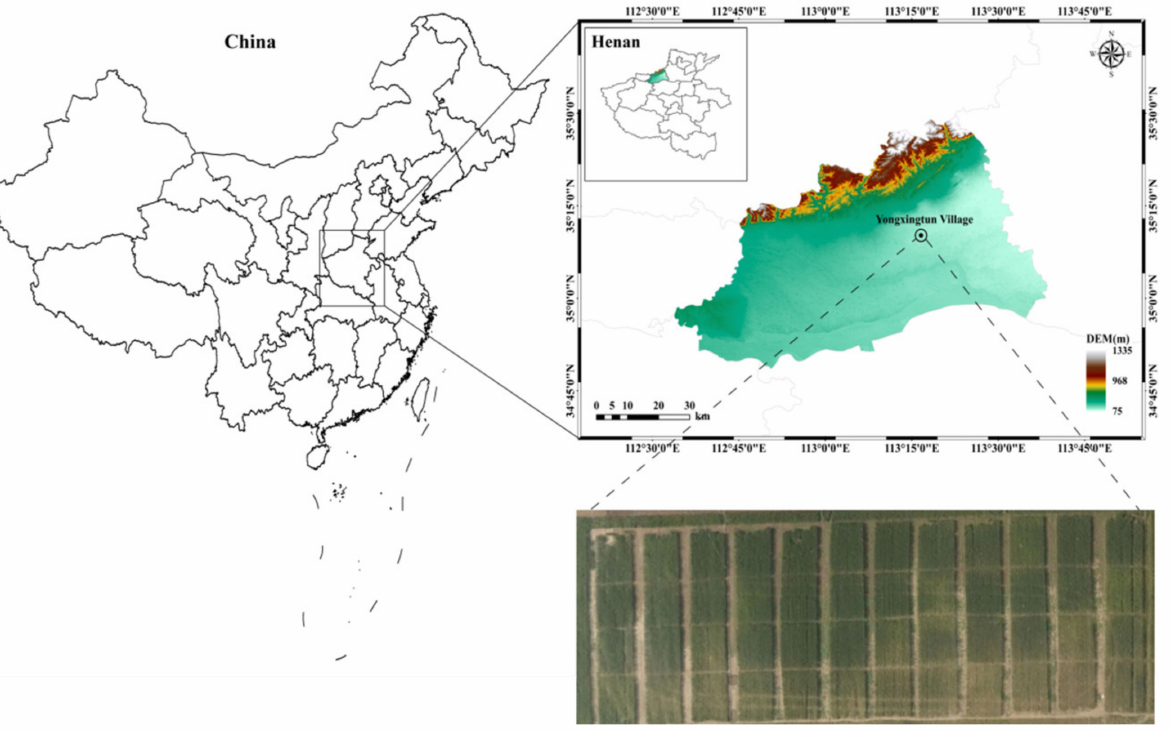
Figure 1. Geographical location of study